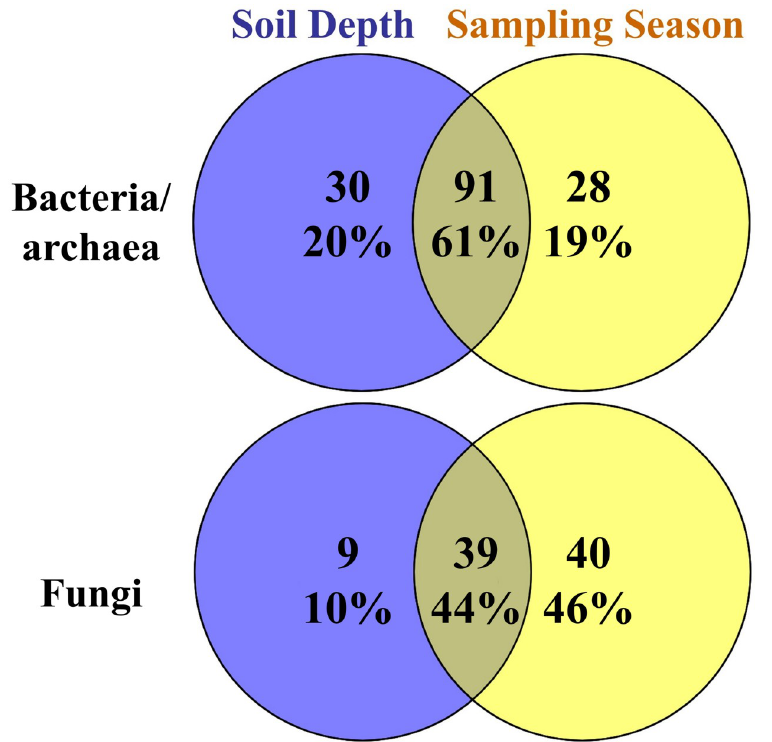
Fig 8. Venn’s diagrams showing significantly affected bacterial/archaeal and fungal dominant taxonomic groups at genus level (average abundances > 0.1%) shared between the factors of soil depth and sampling season.